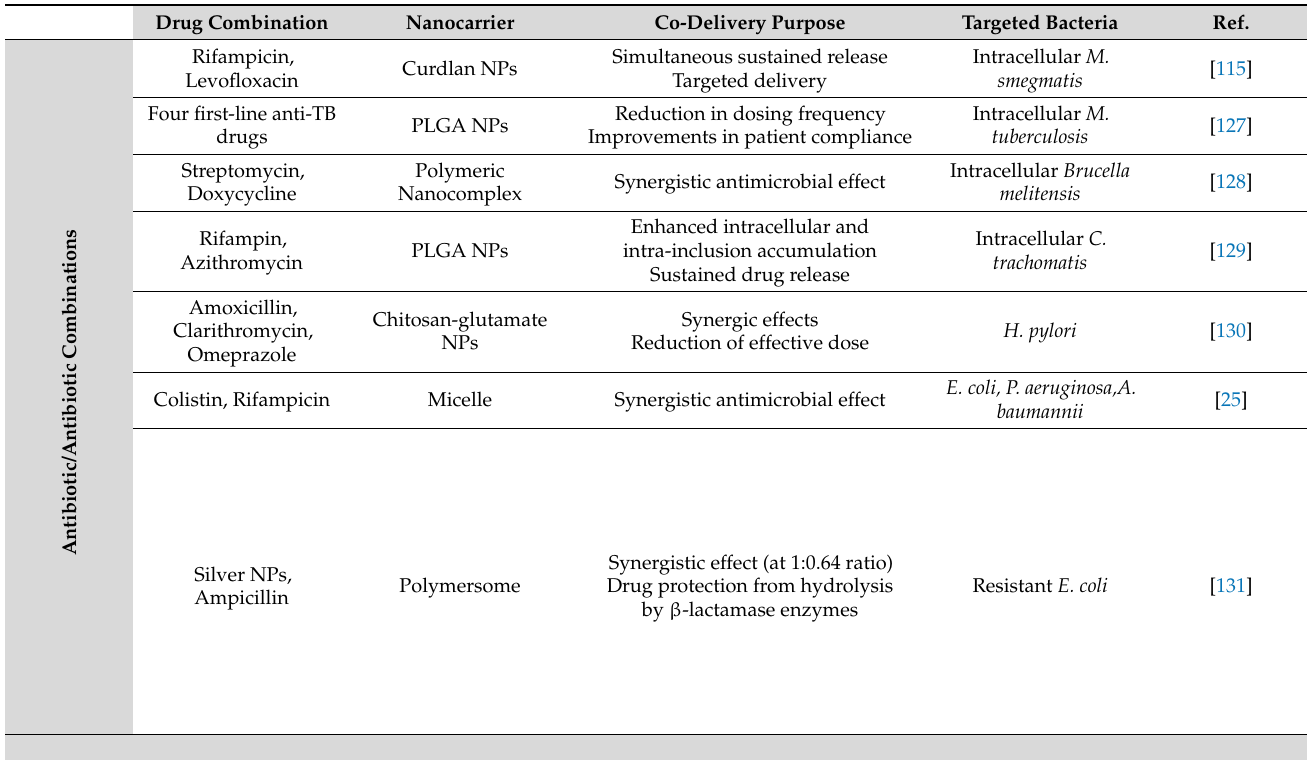
Table 4. Examples of nanocarrier platforms for co-delivery of antibiotic